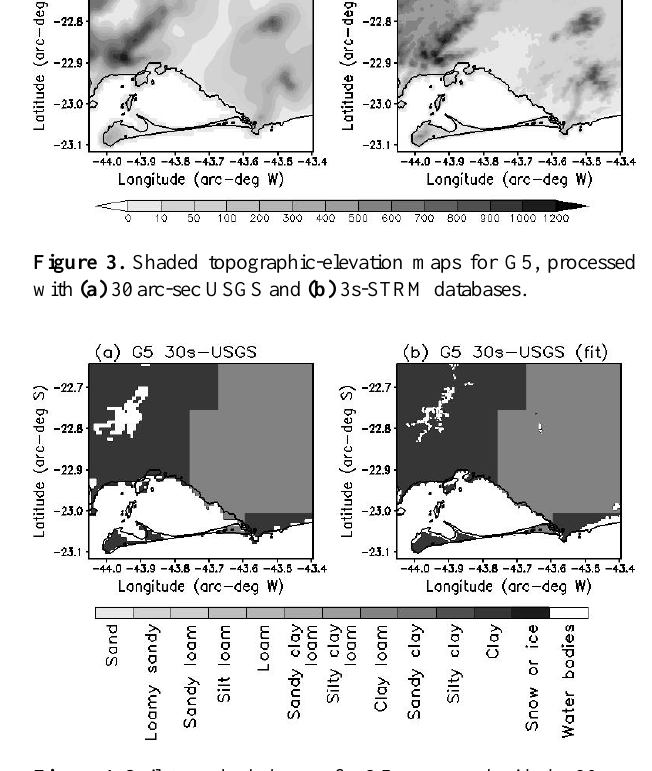
Figure 4. Soil-type shaded maps for G5, processed with the 30arc- sec USGS database: (a) non-fit and (b)